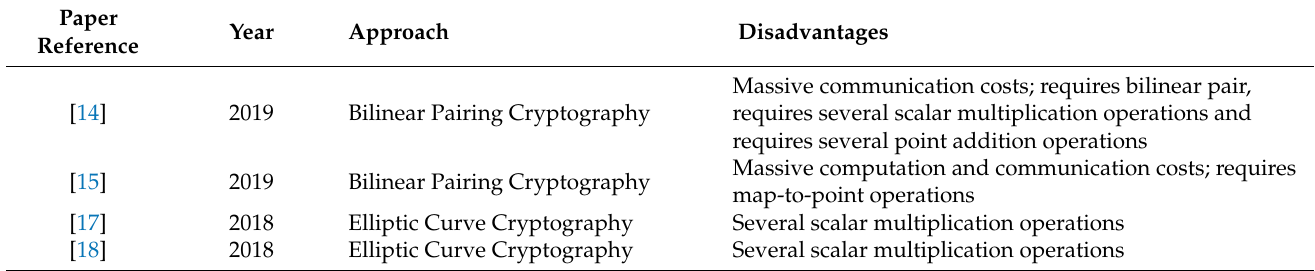
Table 1. Summarizing Related